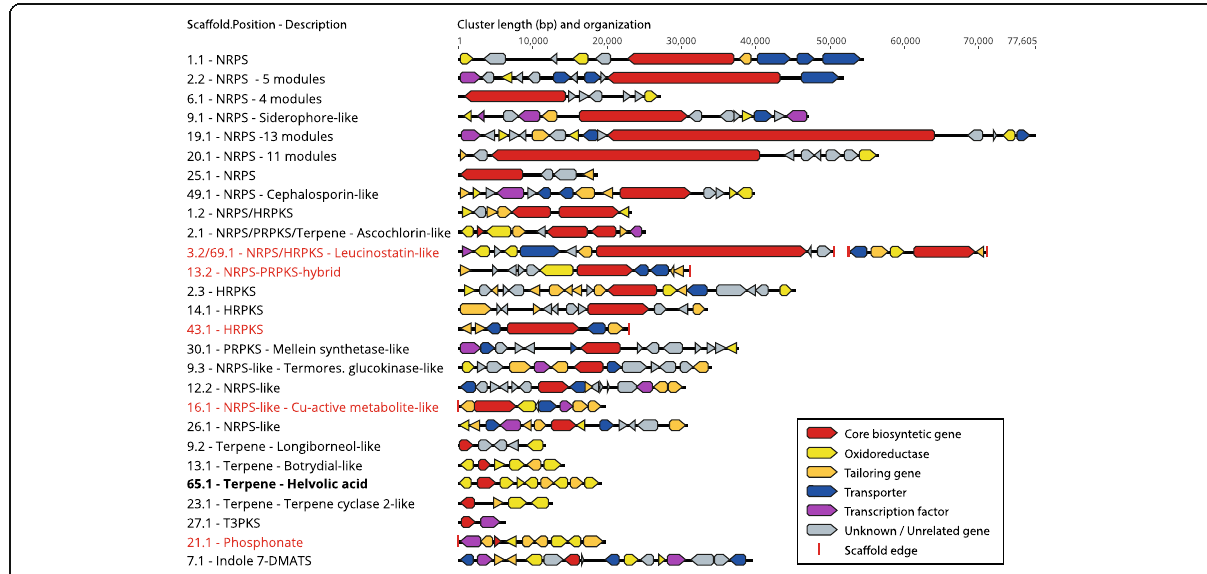
Fig. 5 Overview of BGC structure of the predicted clusters in Emericellopsis sp. TS7 colored after function. Clusters marked in red were on the end of scaffolds and may be incomplete. The leucinostatin-like cluster was split in two, but is presented as one cluster with a gap. Helvolic acid, produced by the cluster in bold, were detected in MS analyses of fermentation